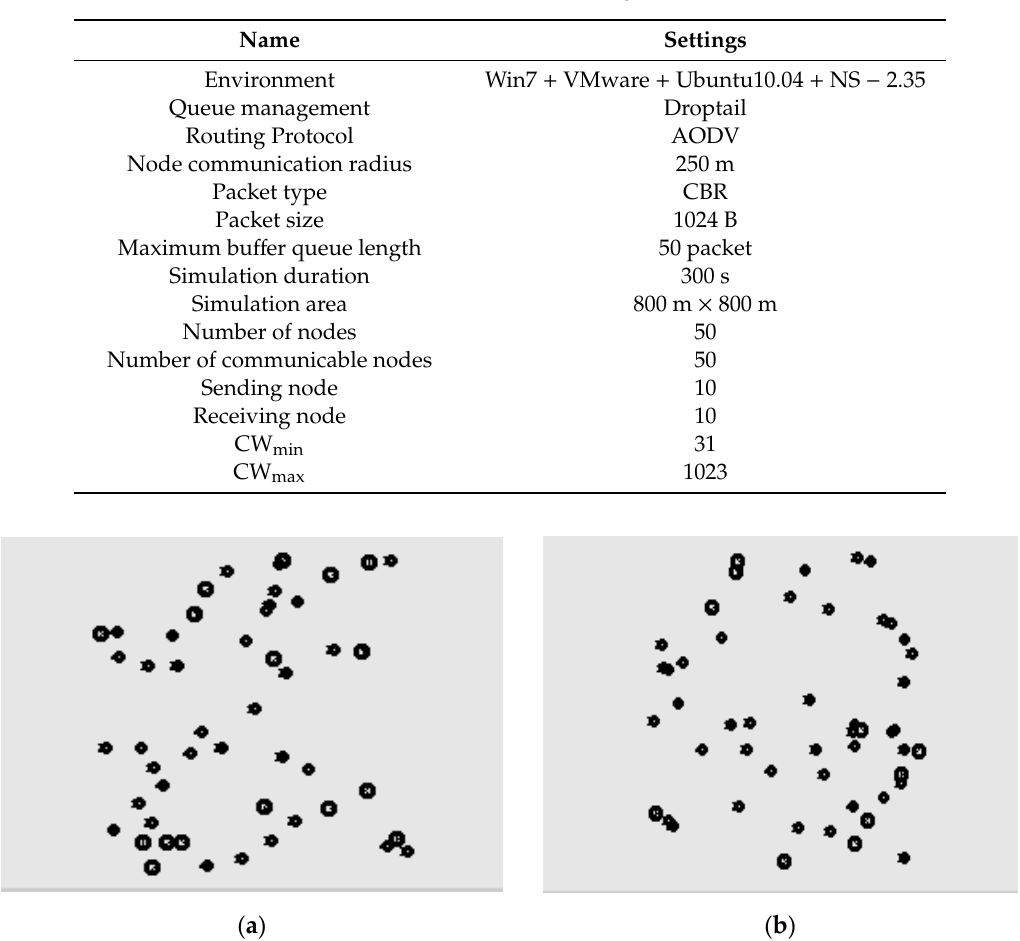
Table 5. Parameter Settings.